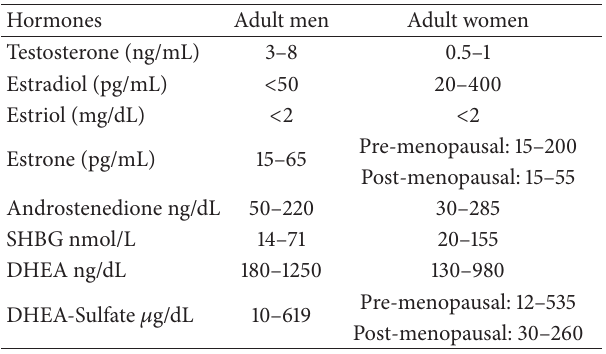
Table 1: Hormone levels commonly recorded in adult men and women. In females, the high variability of estradiol concentration is due to the menstrual cycle variations. Note that testosterone is expressed in ng/mL and estradiol in pg/mL (1ng =